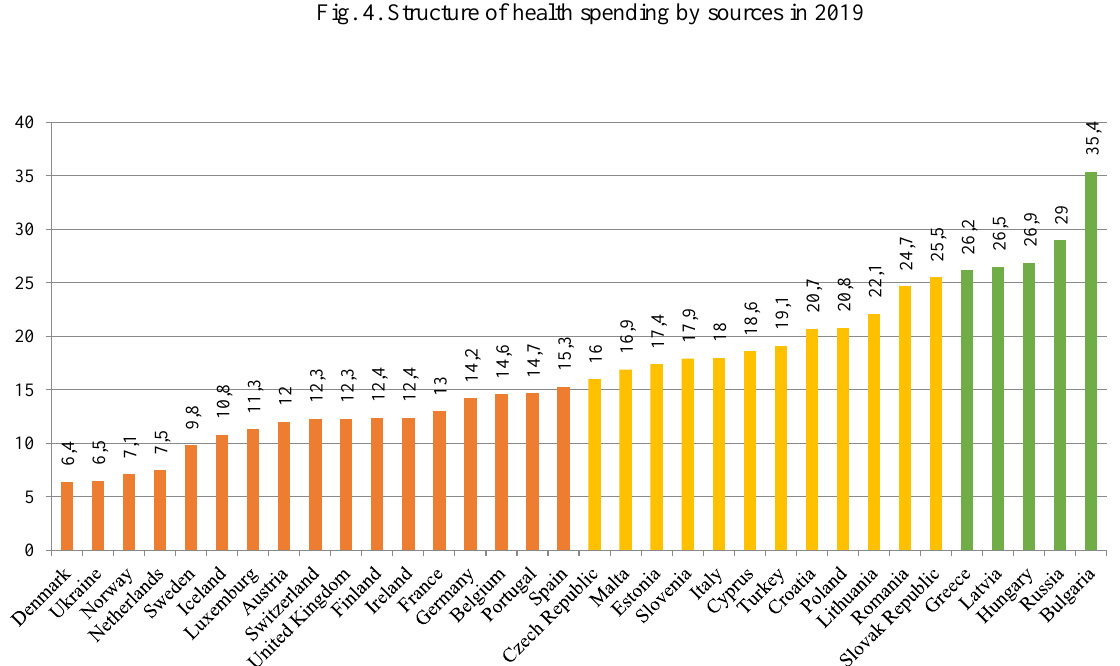
Fig. 5. Level of pharmaceutical expenditure in 2019 (% of health